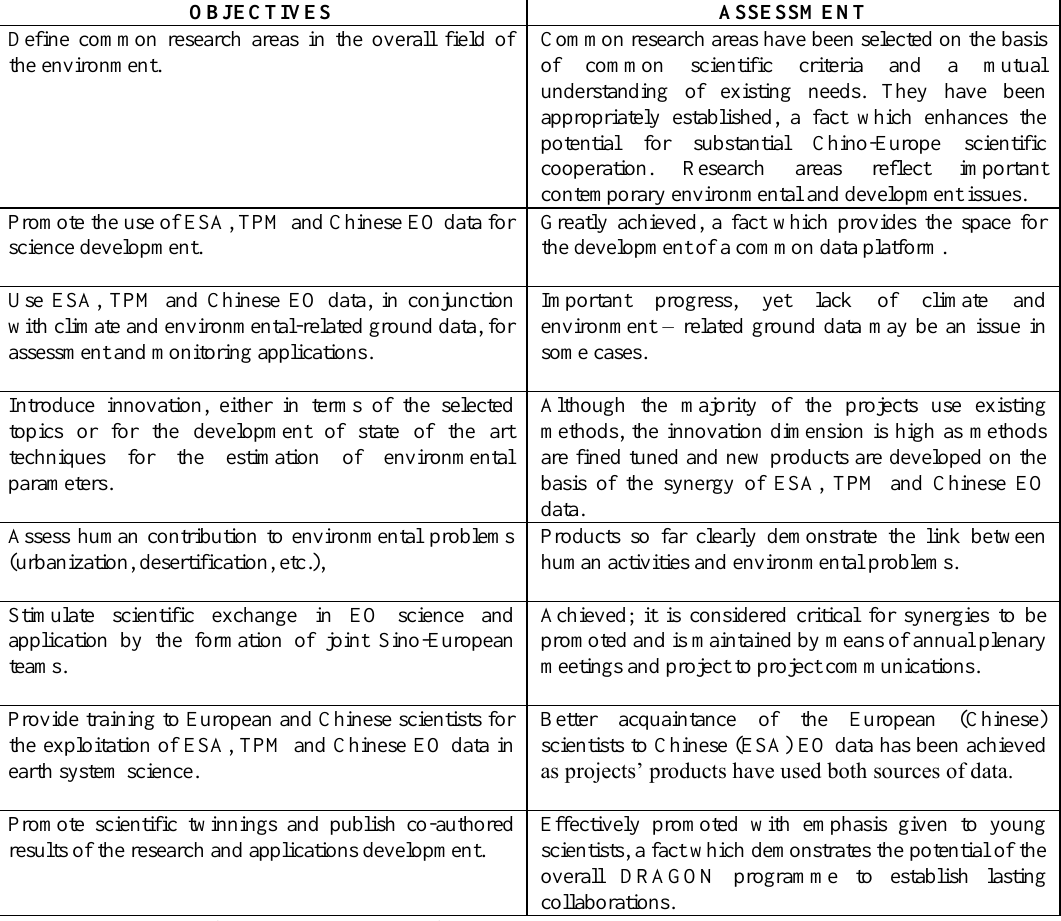
Table 1. Assessment of DRAGON 3 in terms of its objectives. Table 2 summarizes findings and recommendations as they yield from an assessment of the projects’ progress.